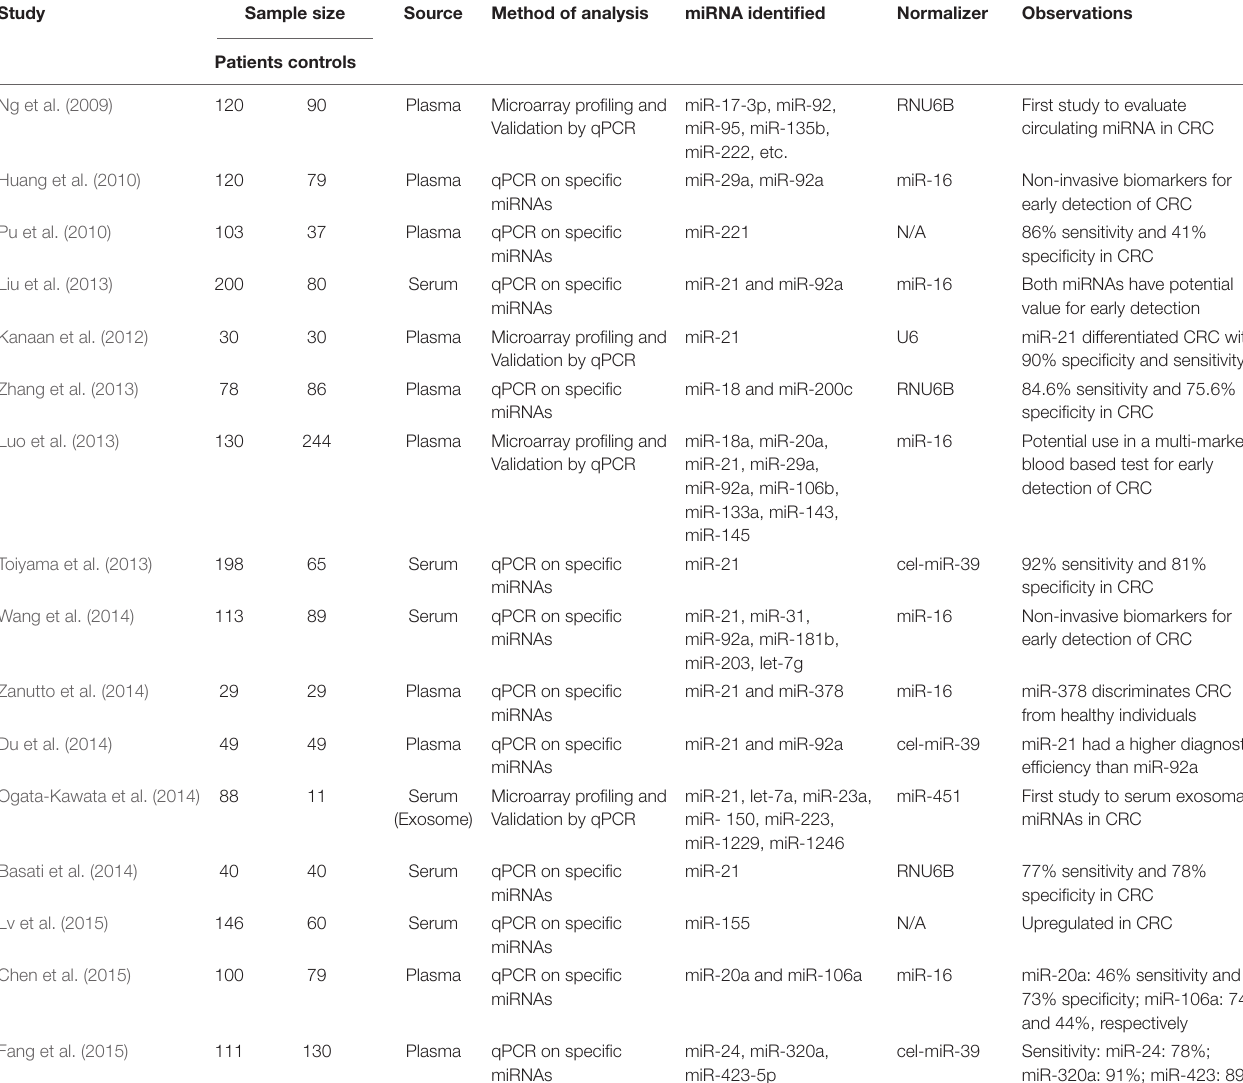
TABLE 2 | Circulating miRNAs changes associated with colorectal